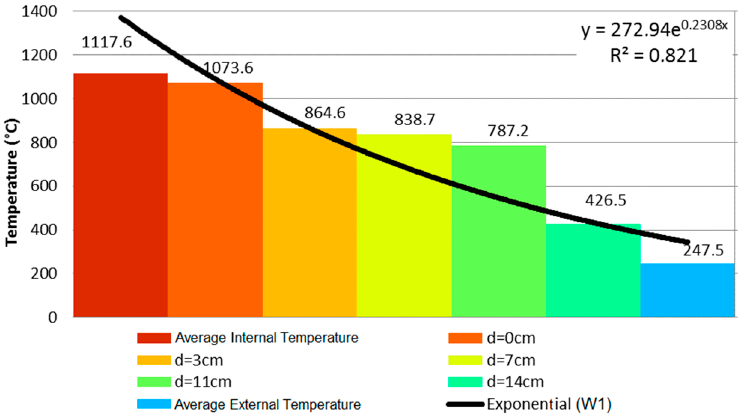
Figure 5. Temperature profile at 240 min—W1.